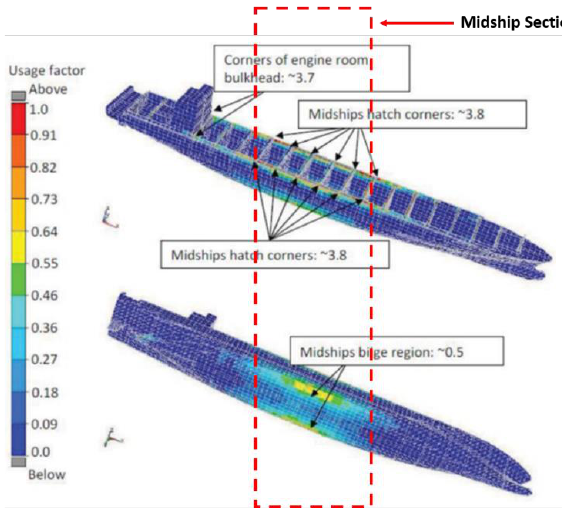
Figure 1. Weakest Areas on Ship Structures [4] Figure 1: Weakest areas on ship structures